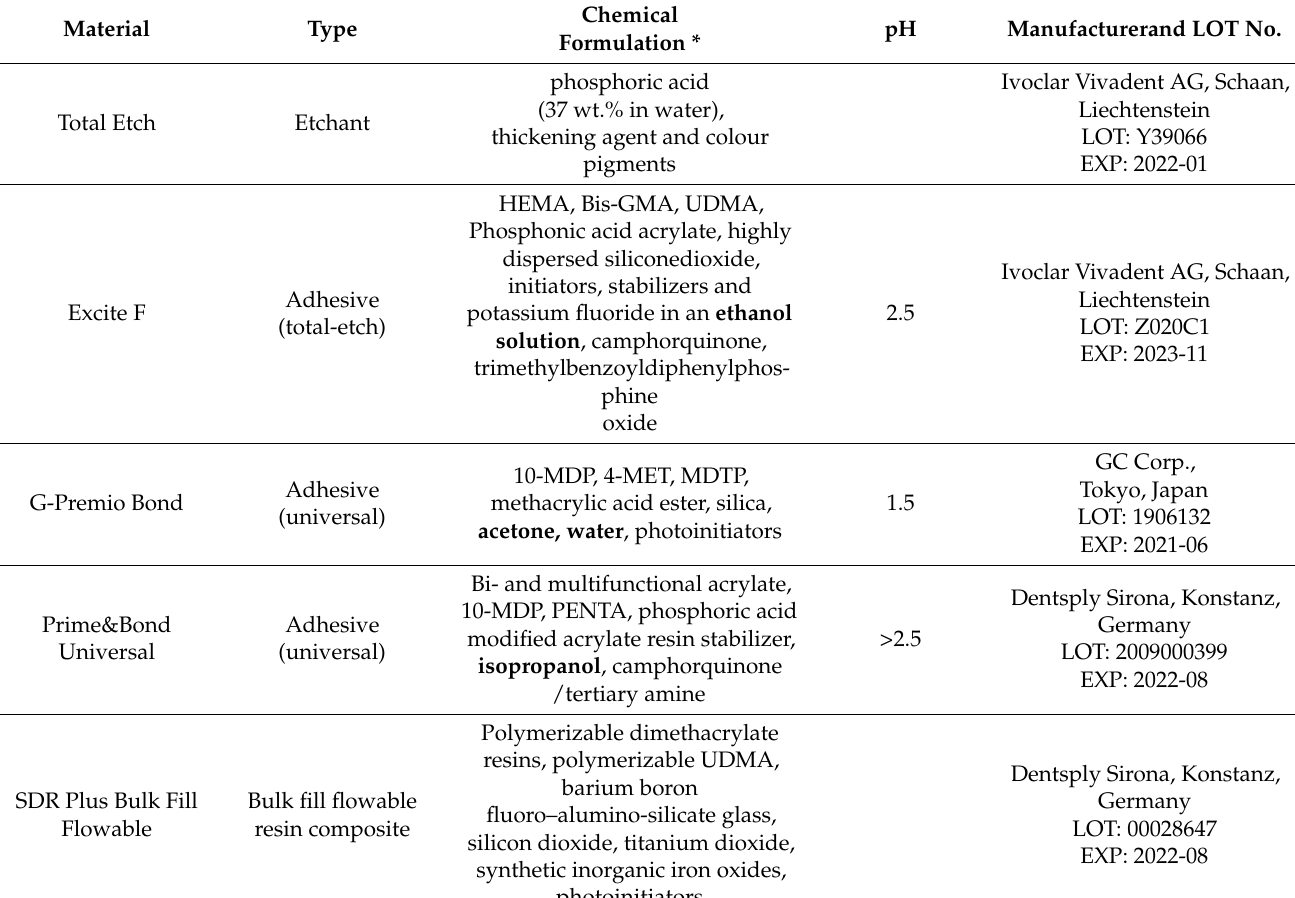
Table 1. Materials used in this study.